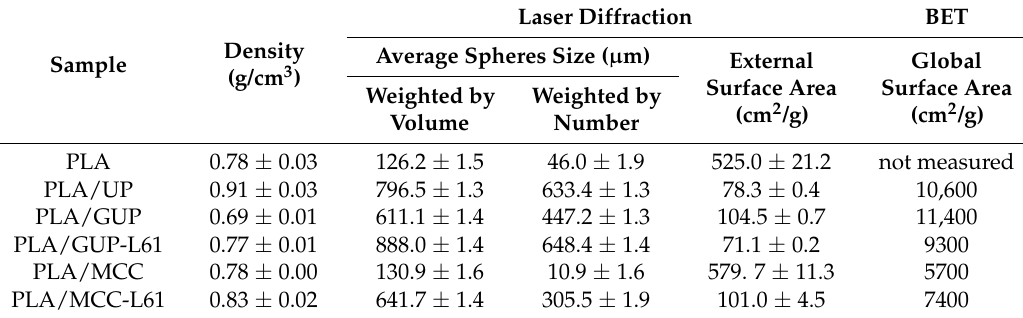
Table 2. Physical properties of selected samples of PLA/cellulose spheres (see Table 1 for sample